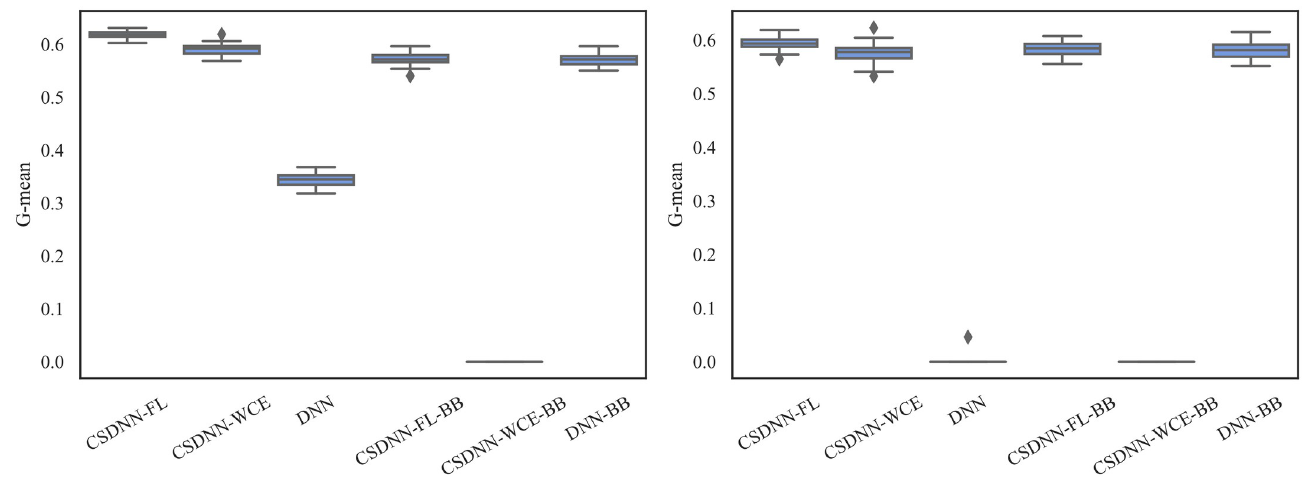
Fig 21. Comparison of CSDNN-FL and CSDNN-WCE versus DNN (in terms of G-mean) on the Full Texas and Oklahoma datasets. Each boxplot denotes variability of the G-mean (vertical axis) for different methods.